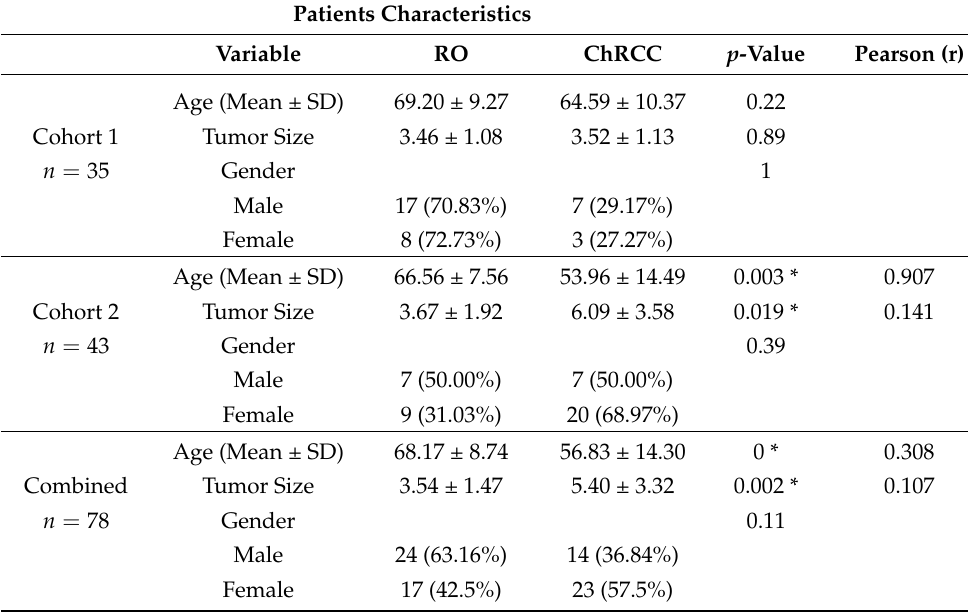
Table 3. Statistical demographic characteristics of the patients’